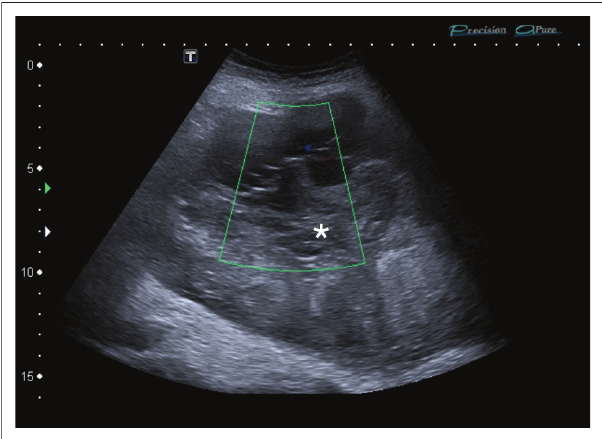
FIGURE 1: Ultrasound image of the mass with Doppler technique, showing a large, heterogeneous and minimally vascularised intra-abdomina mass, situated on the midline and measuring about 25 cm × 20 cm (asterisk).